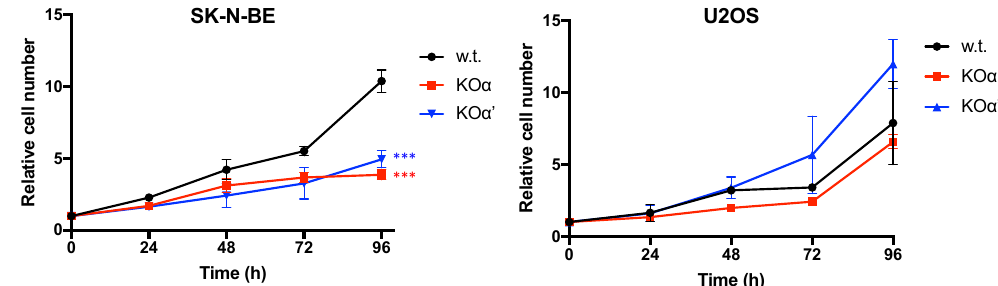
Figure 2. Proliferation curves of w.t. and KO clones of SK-N-BE and U2OS cells. The cell number was evaluated every 24 h, by means of Trypan blue exclusion assay (see methods for details). Experiments were performed in triplicates; at least three independent experiments were performed. The curve for each KO reports the means values ± SEM obtained with the different clones of the same KO. Significance calculated at 96 h refers to w.t. cells. (***) p < 0.001